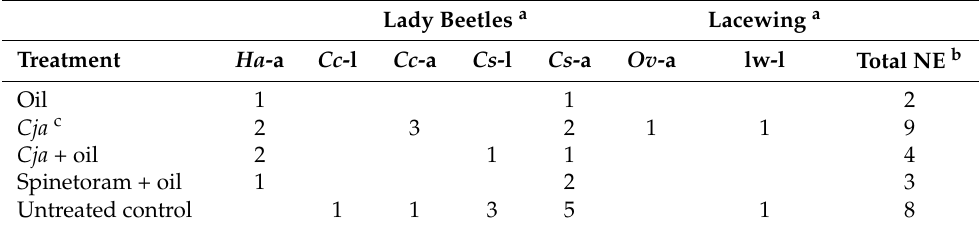
Table 2. Natural enemies of the Asian citrus psyllid detected in stem tap samples in Trial 2. Lady Beetles a Lacewing a